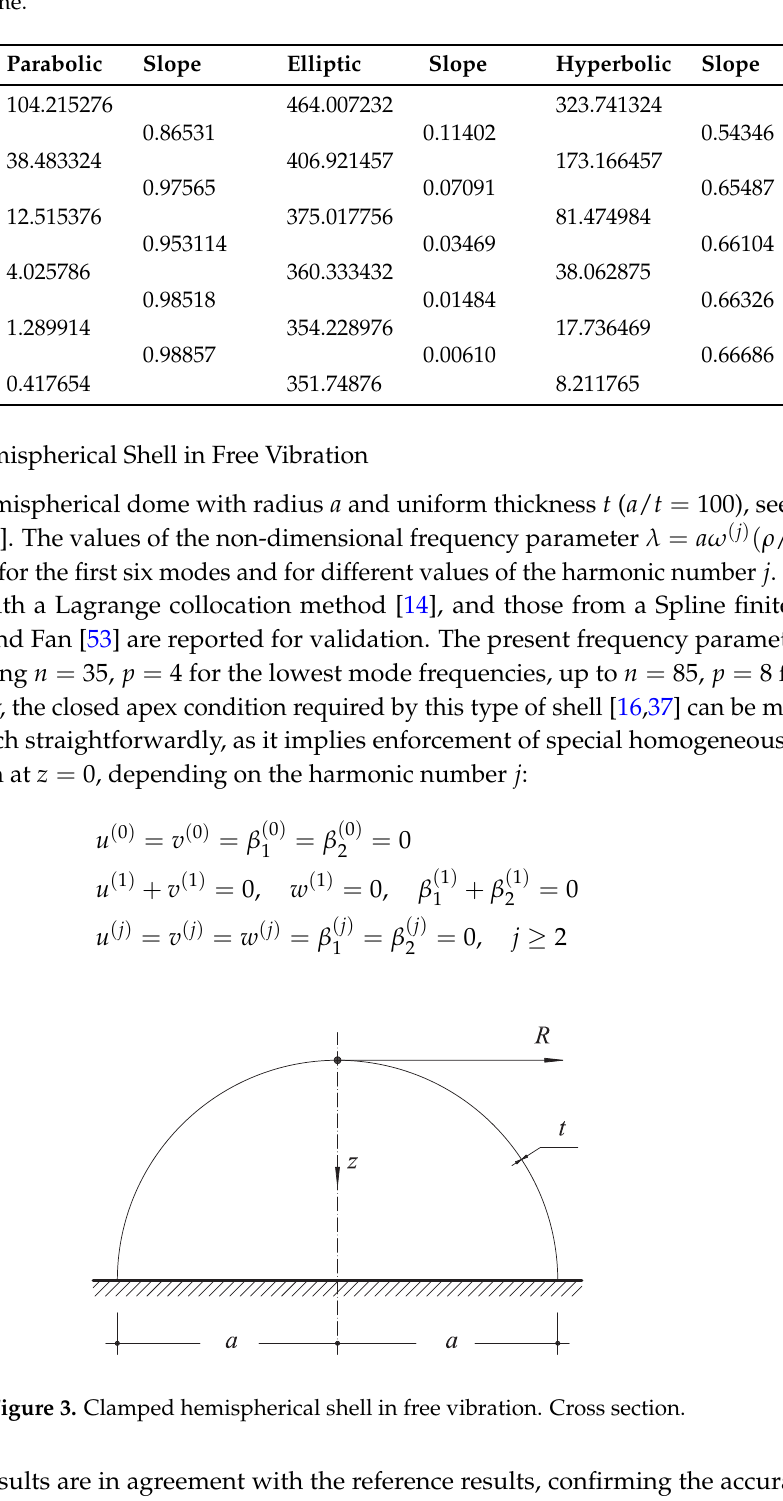
with respect to thickness ratio t / H for 0